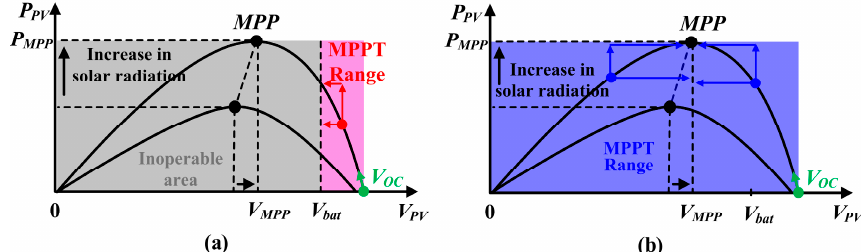
Figure 4. Maximum power point tracking (MPPT) range of ( a ) the converter of [15] and ( b ) the proposed CBB BDC for V MPP < V bat < V PV .